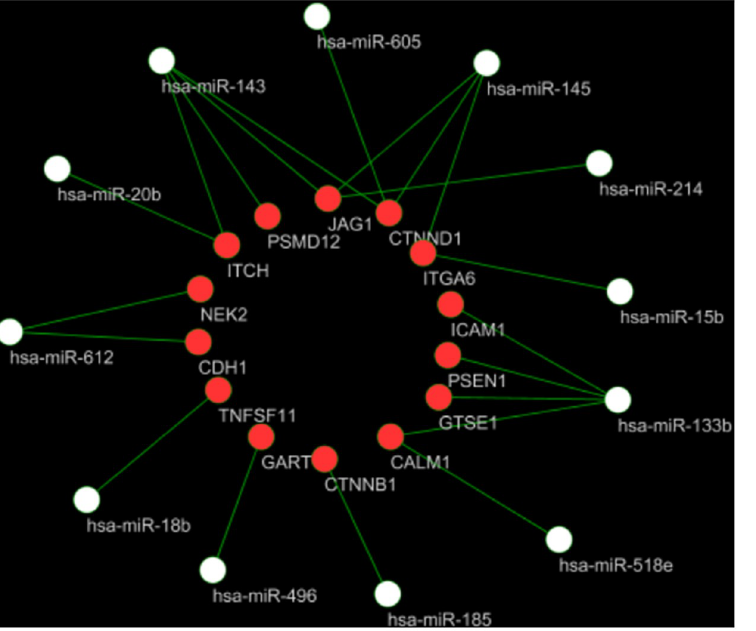
Fig 5. The miRNA-mRNA regulatory network. White nodes, miRNA; Red nodes, mRNA.